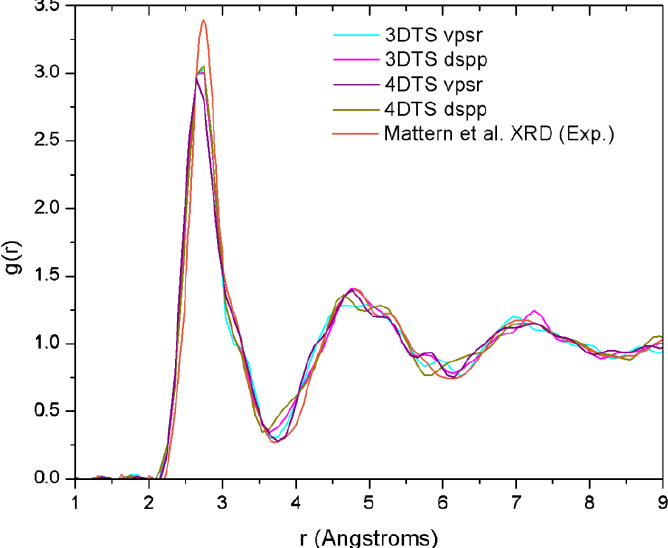
Figure 32. Comparison of our RDFs and the experimental RDF of Mattern et al . Our results were weighted for X-ray scattering in order to compare them with